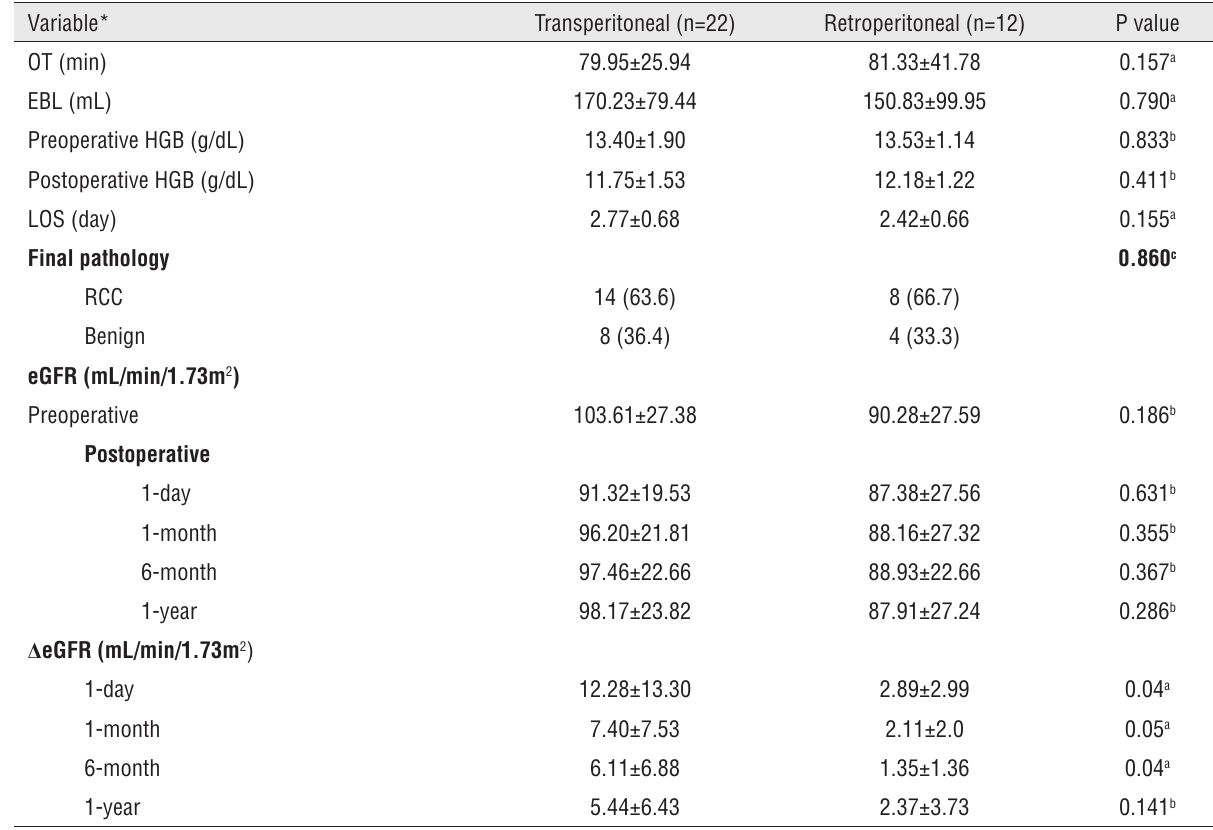
Table 2 - Perioperative, Postoperative and Renal Functional Outcomes. Variable* Transperitoneal (n=22) Retroperitoneal (n=12) P